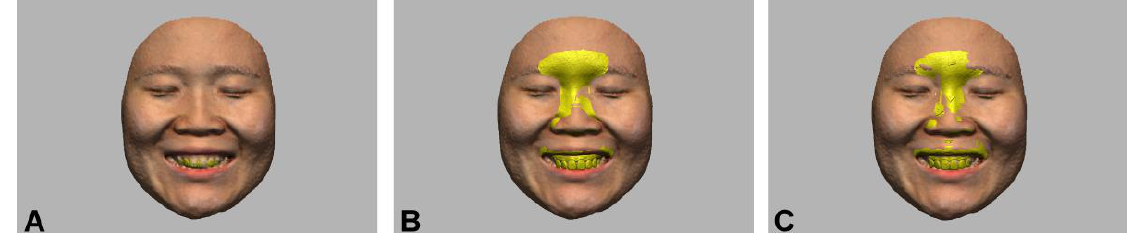
Figure 3. Dentofacial image integration performed using different image matching methods. ( A ) teeth image only; ( B ) teeth and perioral area without marker; ( C ) teeth and perioral area with markers.